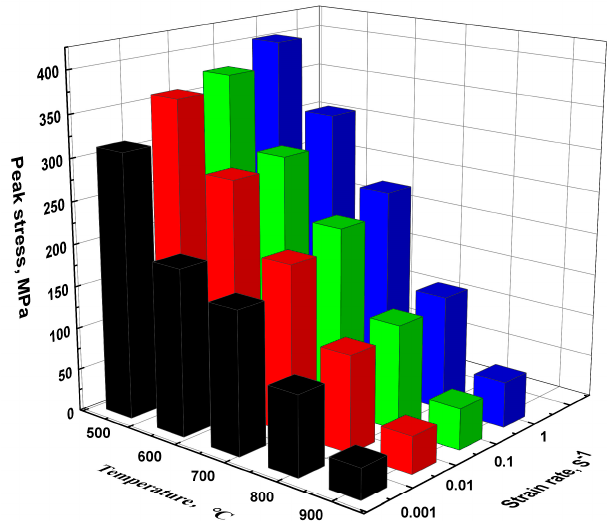
Figure 1. Flow stress–strain curves of the new type of Cu-1.1–Ni-0.7–Co-0.45–Si-0.3Cr alloy at different compression temperatures with different strain rates: ( a ) 0.001 s − 1 , ( b ) 0.01 s − 1 , ( c ) 0. 1 s − 1 , ( d ) 1 s − 1 .